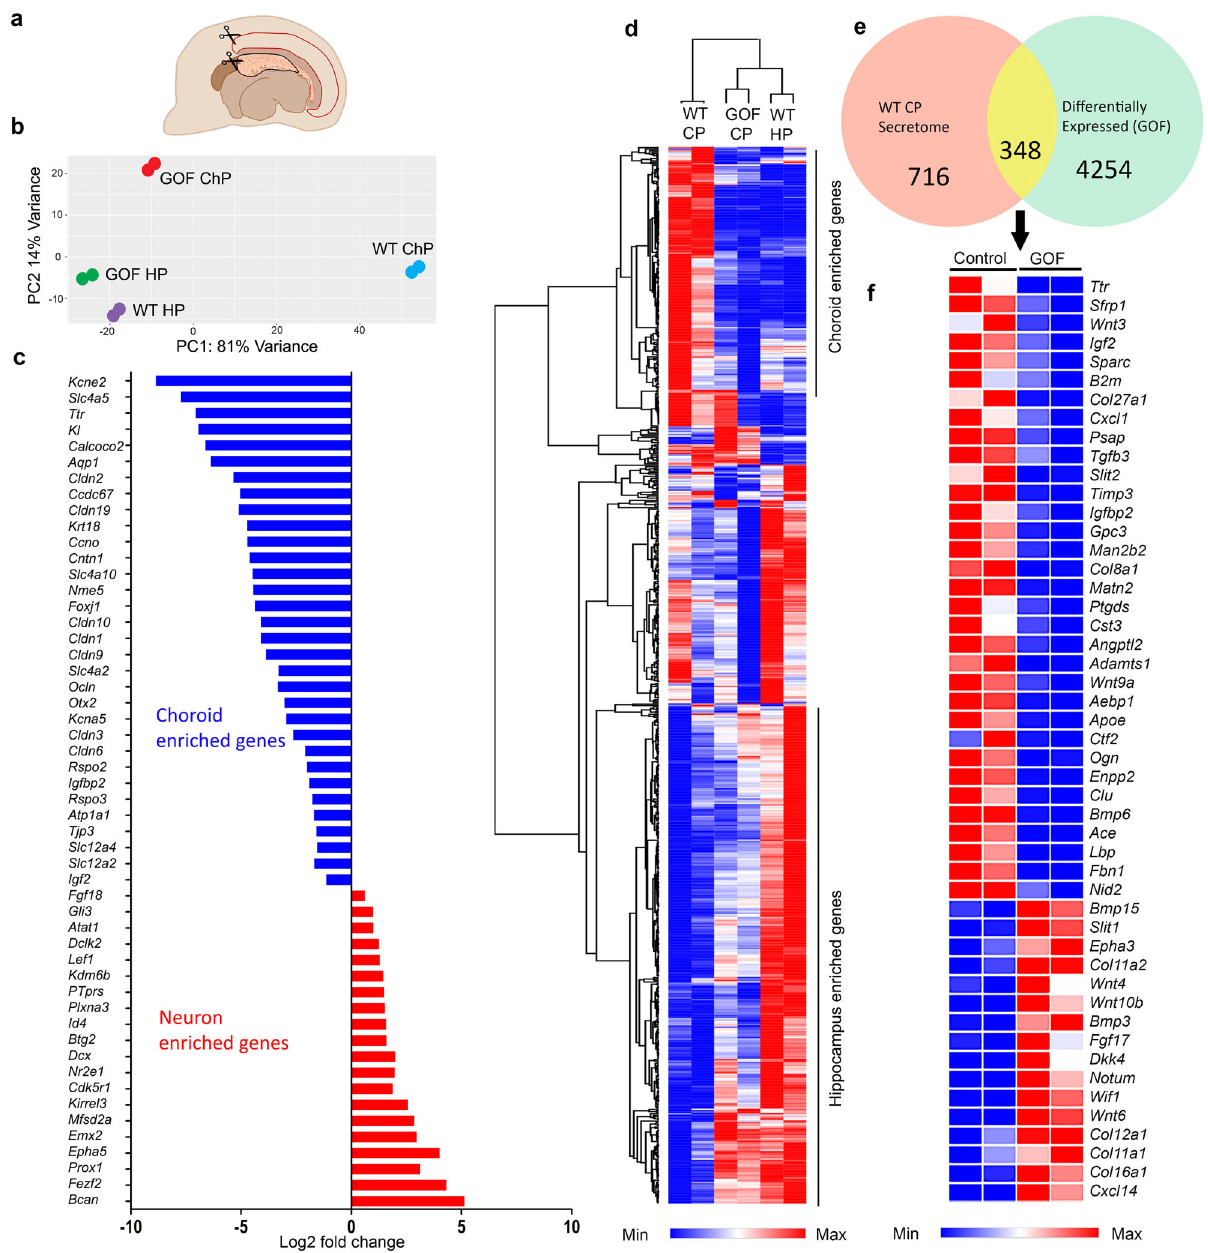
Fig. 7 Constitutive activation of β -CATENIN leads to a dysregulation of the ChP transcriptome. ( a ) A cartoon depicting the microdissection E14.5 ChP and hippocampus for RNAseq analysis. ( b ) Principal Component Analysis (PCA) of the RNAseq datasets. ( c, d ) Choroid plexus-enriched genes are downregulated, and hippocampus/neuron-enriched genes are upregulated in the Lmx1aCre:: β -catenin GOF ChP. In ( c ) log2 fold changes of 31 representative choroid plexus-enriched genes and 20 neuron-enriched genes are plotted (Padj < 0.05), ( d ) heatmap and hierarchical clustering show read counts of 500 choroid enriched and 500 hippocampus enriched genes from the RNA-seq dataset (Supplementary data 1). ( e, f ) Venn diagram showing the overlap between genes corresponding to the ChP secretome (from Lun et al. 2015.) and differentially expressed genes in the Lmx1aCre:: β -catenin GOF versus control ChP and heat map of selected genes plotted as read counts ( e ) shows the dysregulated genes belong to various known pathways of cell-cell signaling ( f ). Color bars in ( d, f ): blue (low expression), red (high expression). For RNAseq experiments ( c, d, and f ) N = 2 biologically independent replicates. Further information on replicates and reproducibility for this fi gure is mentioned in the “ Statistics and Reproducibility ” section of the Methods and Supplementary data 1. Source data are provided as a Source Data fi CTCTGTCTATTC3 ′ ; RM43 5 ′ TACACTATTGAATCACAGGGACTT3 ′ 31 . The wherever possible. Control embryos/pups carrying the Ai9 reporter to mark the Lmx1a or Foxj1 lineage carried the respective Cre transgenes. Breeding colonies PCR shows 221 bp as Wild type band while 324 bp as band corresponding to fl oxed were maintained with the female breeders carrying the Lmx1aCre and Foxj1Cre allele. For genotyping β -catenin GOF (Exon 3 fl oxed) FP 5 ′ GCTGCGTGGA- transgenes since this germline recombination occurs in the testes of these lines. CAATGGCTAC3 ′ and RP 5 ′ GCTTTTCTGTCCGGCTCCAT3 ′ 26 was used which Primers used for genotyping were: Cre F: 5 ′ ATTTGCCTGCATTACCGGT detects conditional allele at 550bp and wild type band at 350 bp in PCR. C3 ′ , Cre R: 5 ′ ATCAACGTTTTCTTTTCGG3 ′ , Cre-positive DNA shows a band at 350 bp. For detecting β -catenin LOF (Exon2 – 6 fl oxed) following primers were Human . The Institutional Ethical Review Board of the School of Medicine, Uni- used: RM41 5 ′ AAGGTAGAG TGATGAAAGTTGTT3 ′ ; RM42 5 ′ CACCATGTC versity of Zagreb, and University Hospital Center Zagreb have approved the